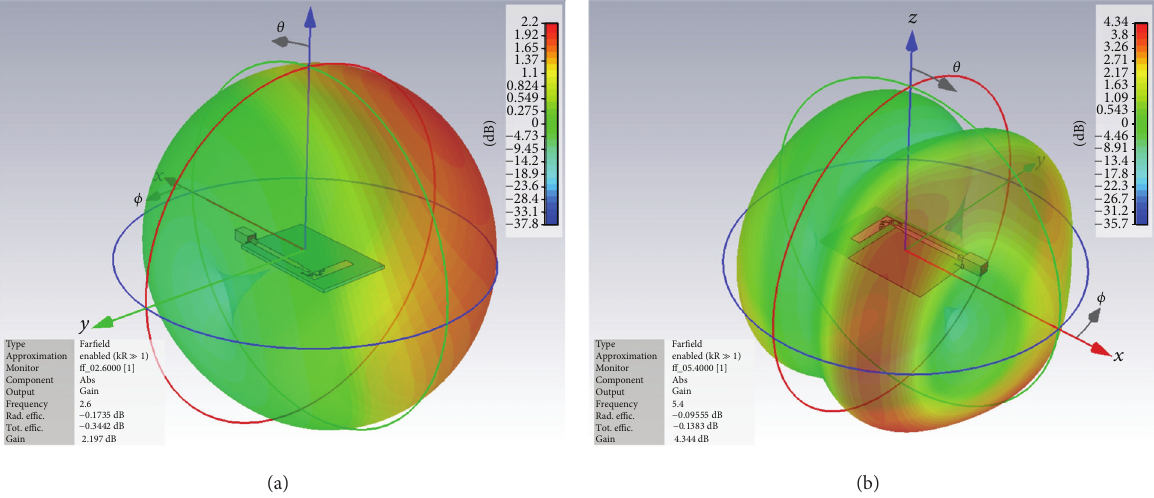
Figure 16: Numerically estimated three-dimensional gain patterns of the K2 PIFA at (a) 2.6 GHz and (b) 5.4 GHz. Notice the different amplitude scales (both are given in